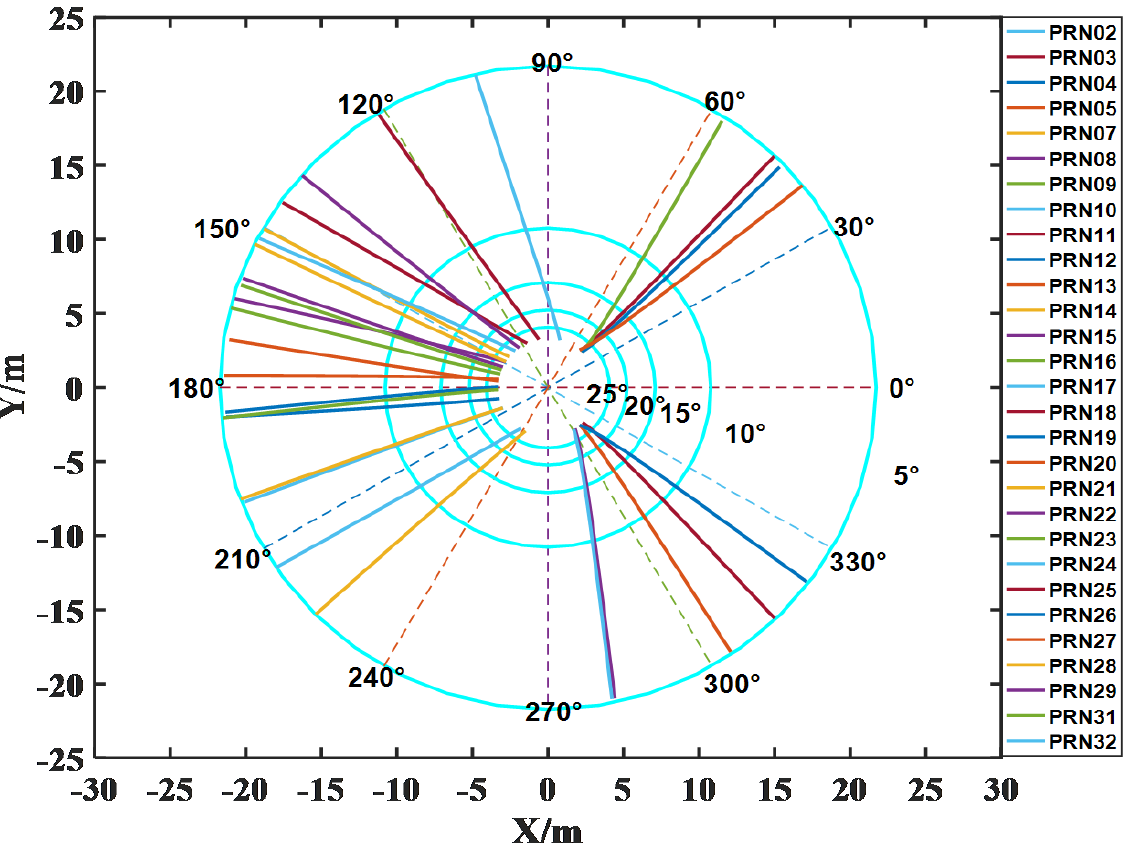
Figure 9. The projected trajectory of the P041 (DOY: 2014-065) satellite at an elevation of 5 – 25°.